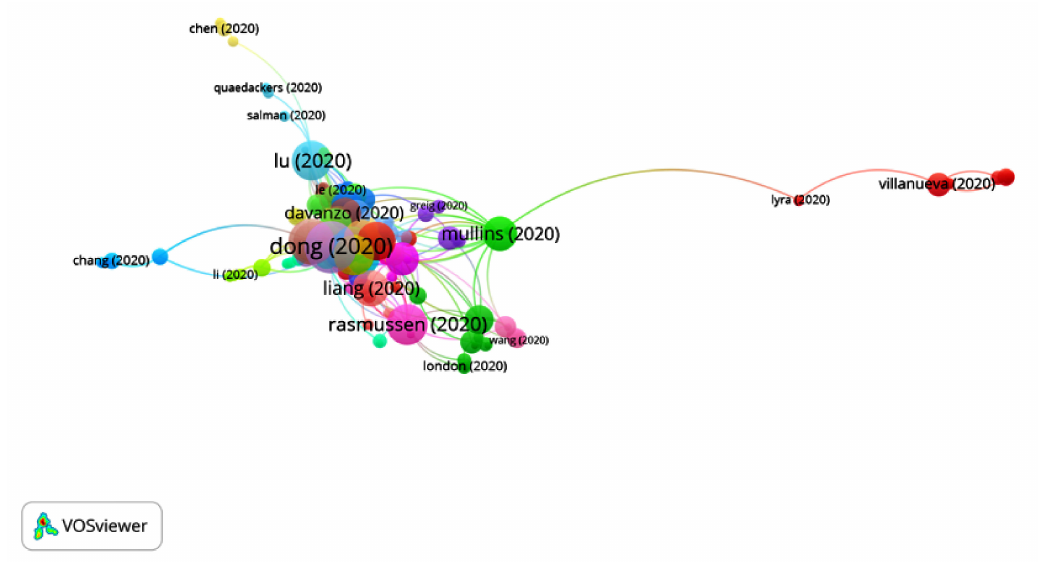
Figure 13. Citation network for Group 7.